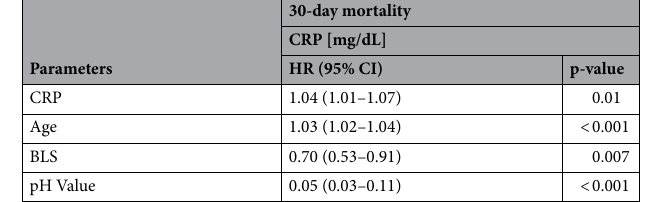
Table 3. Multivariate analysis of the secondary endpoint (n = 832). 30-day mortality was assessed by the Cox regression model using a backward stepwise elimination approach according to Wald test statistic step-by- step. The presented parameters are the ones remaining in the final step of the model. BLS basic life support, CI confidence interval, CRP C-reactive protein, HR hazard ratio.